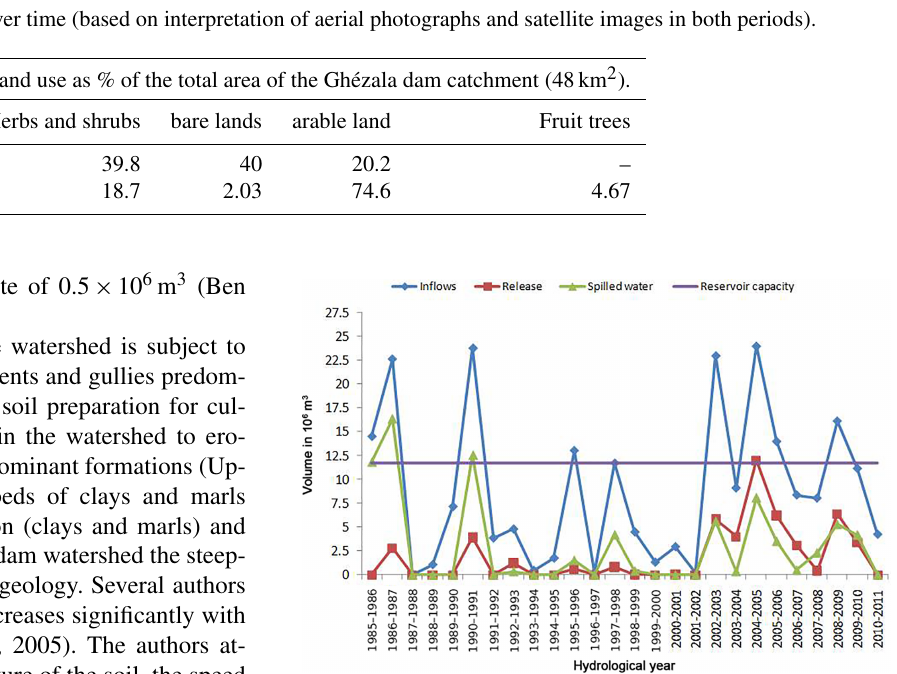
Table 4. Increase in agricultural area over time (based on interpretation of aerial photographs and satellite images in both periods).